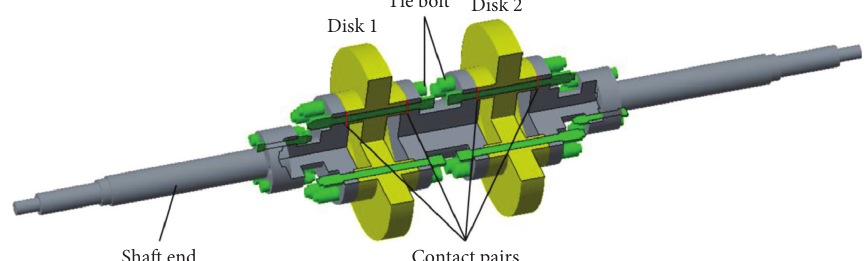
Figure 1: Schematic display of the tie-bolt rotor.